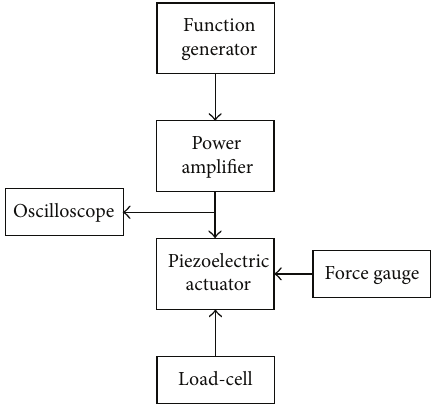
Figure 8: Setup of thrust measurement experiment.